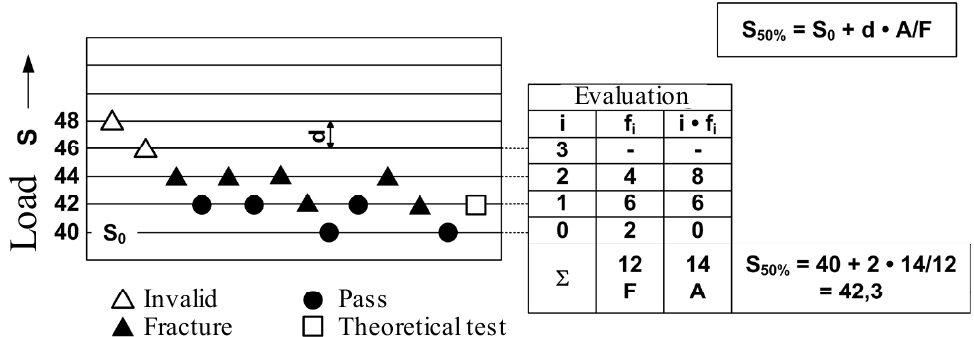
Figure 5. Exemplary evaluation according to Hück staircase method; example extracted from [25].